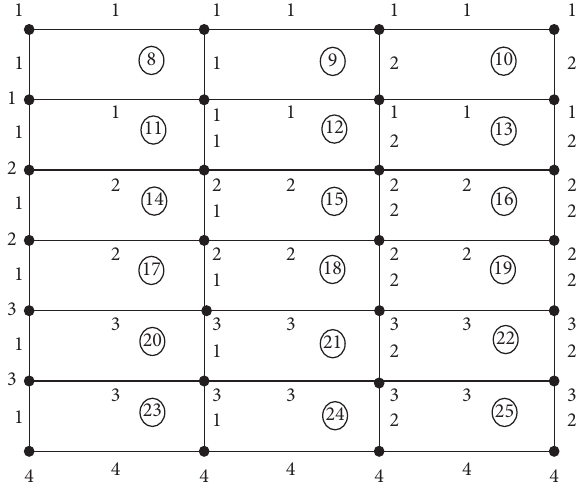
Figure 2: Total face irregular 4-labeling of the (1, 1, 0) of grid graph G 3